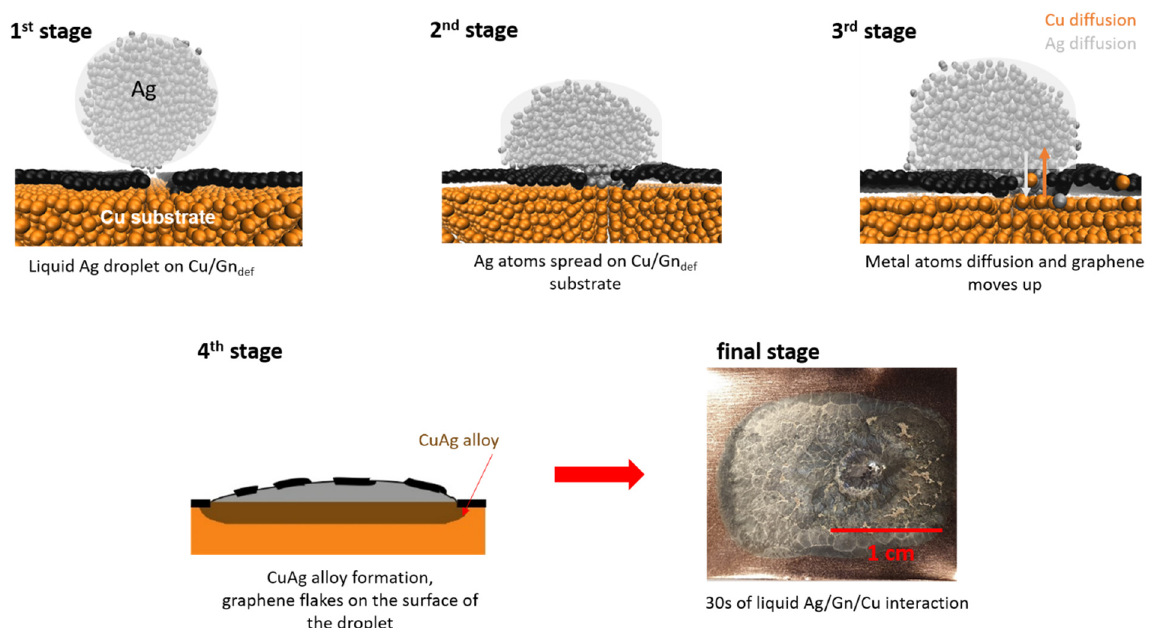
Figure 2. Mechanism of Cu/Gn def substrate wetted with liquid Ag droplet.